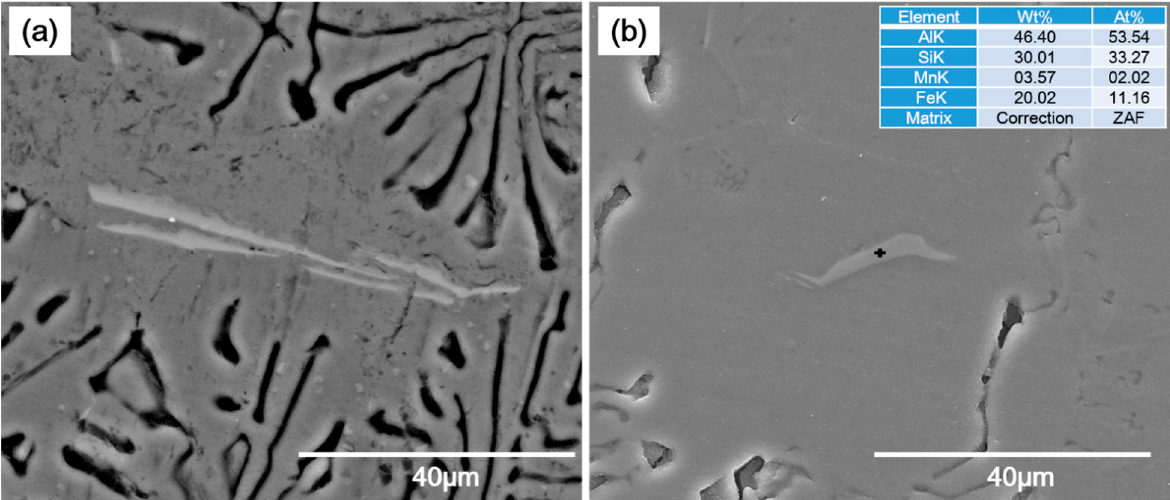
Figure 7. SEM microstructures of as-cast A1 alloy ( a ) and E1 alloy ( b ), showing the relative size of iron-bearing phases in these investigated alloys. A table on the right upper corner shows the EDS-analysis result of the point indicated with a plus sign in ( b ).